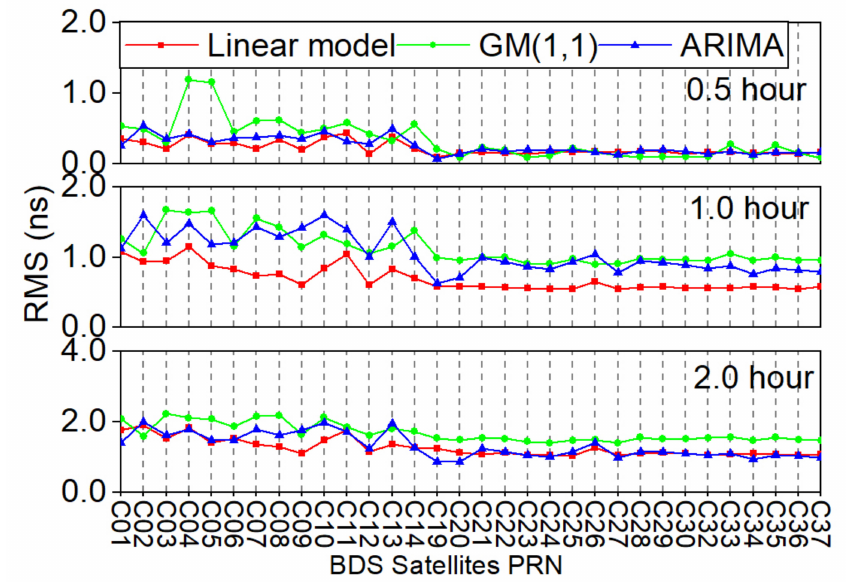
Figure 10. Clock accuracy of predicting 0.5 h, 1.0 h, and 2.0 h satellite clock offsets with the linear model, the grey model, and the ARIMA model.